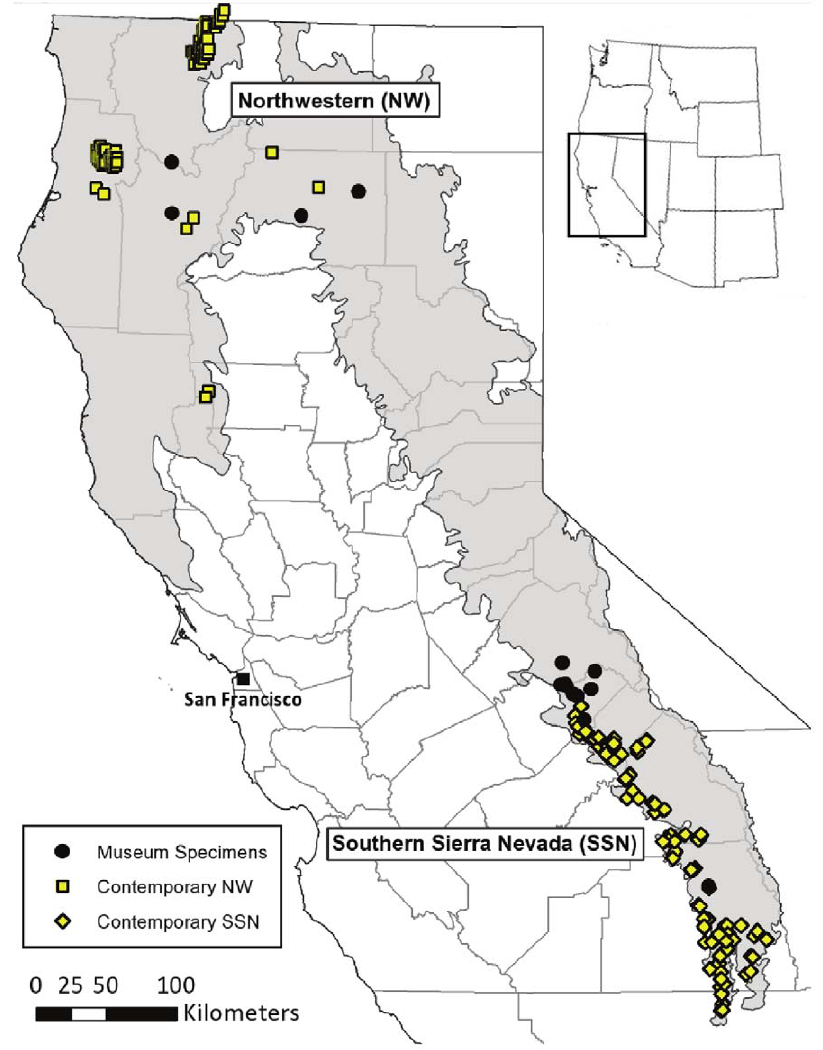
Figure 2. Sample locations. Locations of the historical (H) and contemporary (C) genetic samples from the northwestern mountains (NW) and southern Sierra Nevada (SSN) of California. Sample size is as follows: NW H n=5, SSN H n=16, NW C n=148, SSN C n=127. Grinnell’s assumed historical range as adapted by Davis et al. [115] is shown in gray.